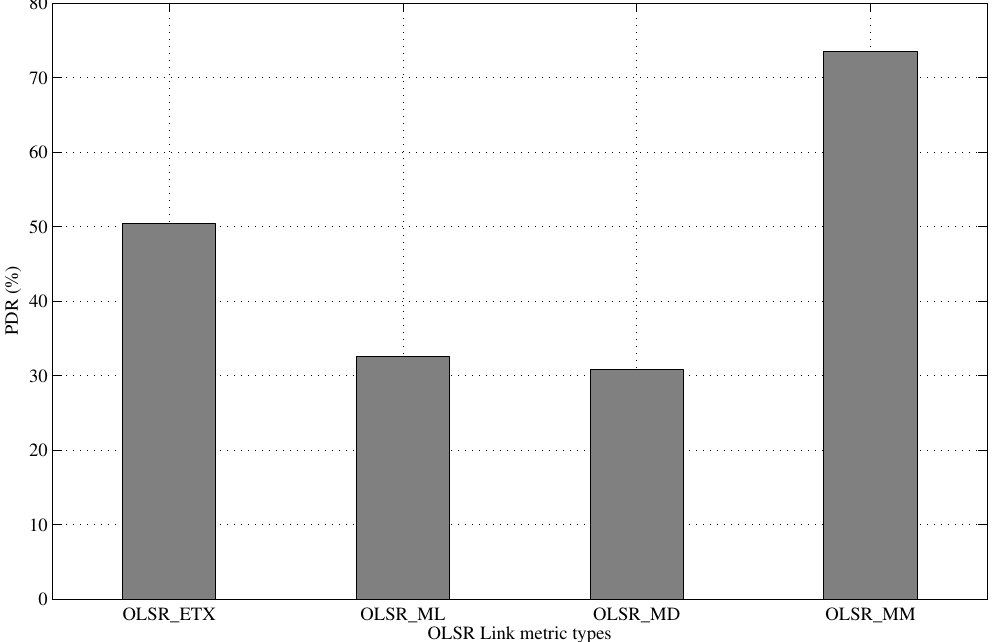
Figure 9. Average PDR for all AMI application traffic